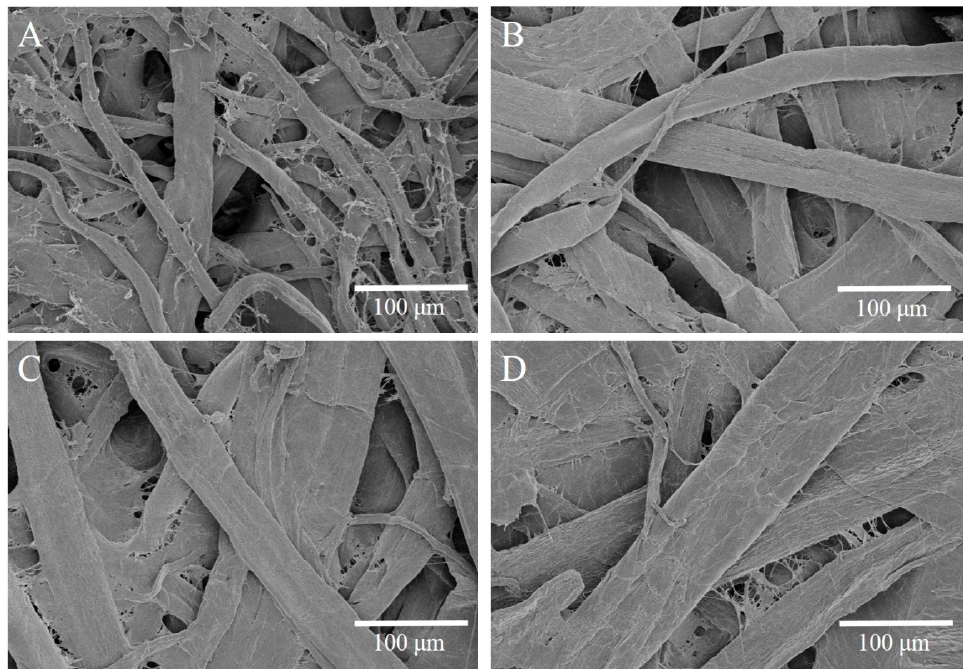
Figure 2. SEM images for different paper samples: ( A ) original paper; ( B )–( D ) paper modified with a ( ε -PL/CMC) 1 , ( ε -PL/CMC) 3 , and ( ε -PL/CMC) 5 multilayers,